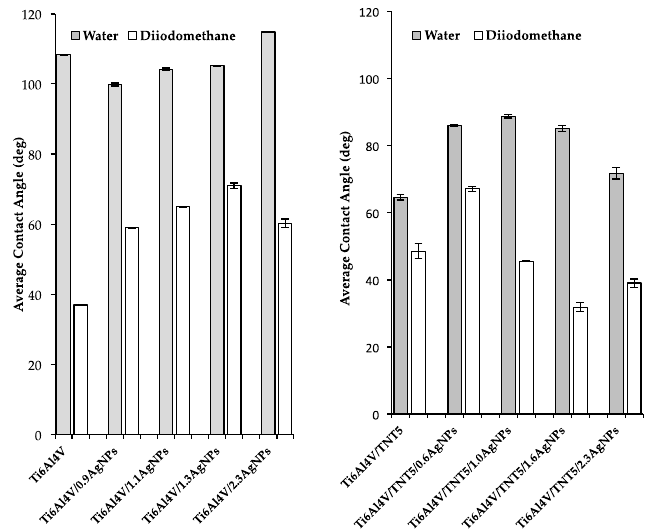
Figure 5. The contact angles values for Ti6Al4V, Ti6Al4V/AgNPs, Ti6Al4V/TNT5, and Ti6Al4V/TNT5/AgNPs.